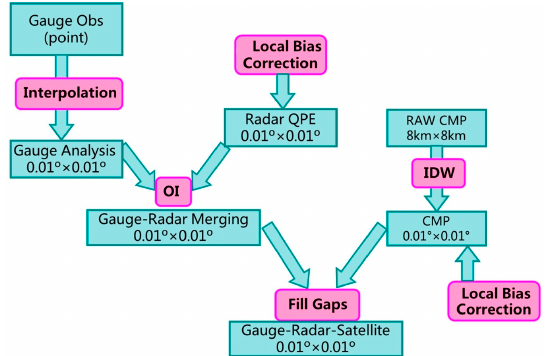
Figure 4. Flowchart of the hourly gauge-radar-satellite precipitation merging algorithm at the 0.01 degree lat./lon. grid box. In this figure, the term Gauge Obs, ‘CMP’ and ‘QPE‘ mean the gauge precipitation observations, CMORPH satellite precipitation dataset and the quantitative precipitation estimation derived from weather radar.